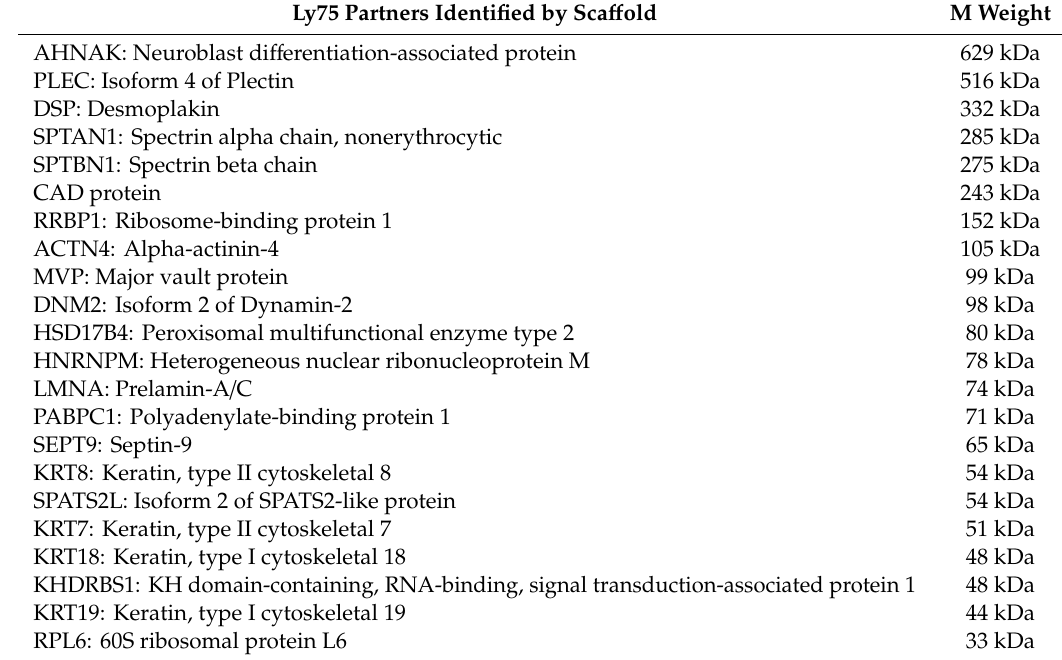
Table 2. Ly75 partners identified by the immunoprecipitation experiments. Ly75 Partners Identified by Sca ff